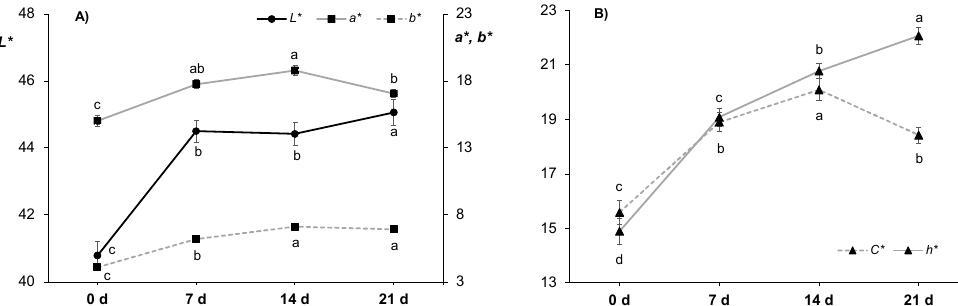
Figure 2. Effect of ageing time (0, 7, 14 and 21 days) on instrumental color measurements in horse longissimus thoracis and lumborum muscle ( n = 20): ( A ) L * (left axis), a * and b * (right axis), and ( B ) C * and h *. Different letters indicate statistically significant differences ( p ≤ 0.05).